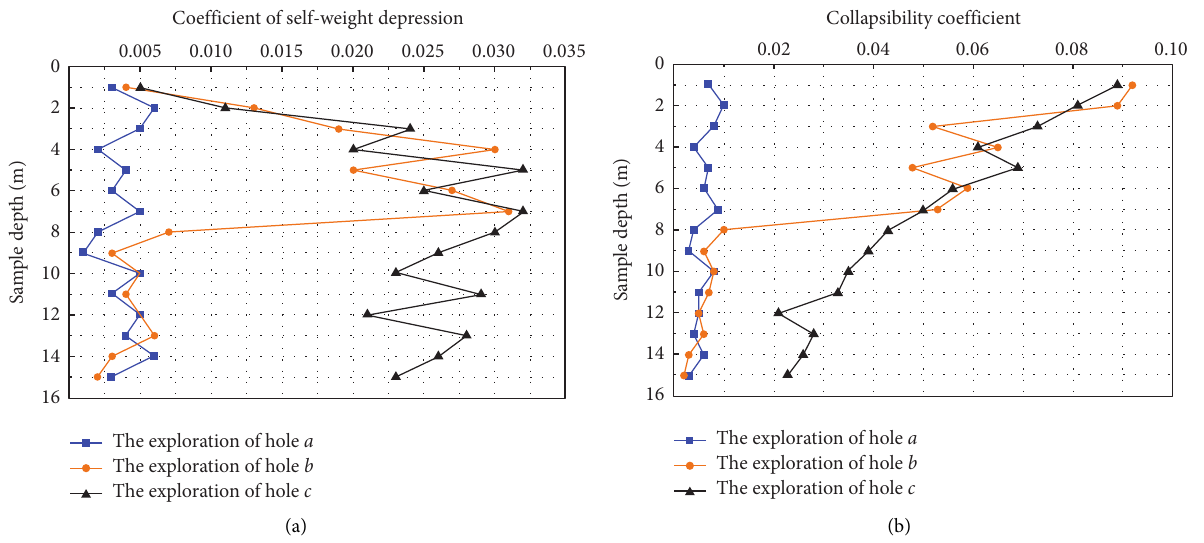
Figure 14: (a) Self-weight coefficient of soil samples with different pore depth change curves. (b) Change curve of the collapsibility coefficient for pore soil samples with layer